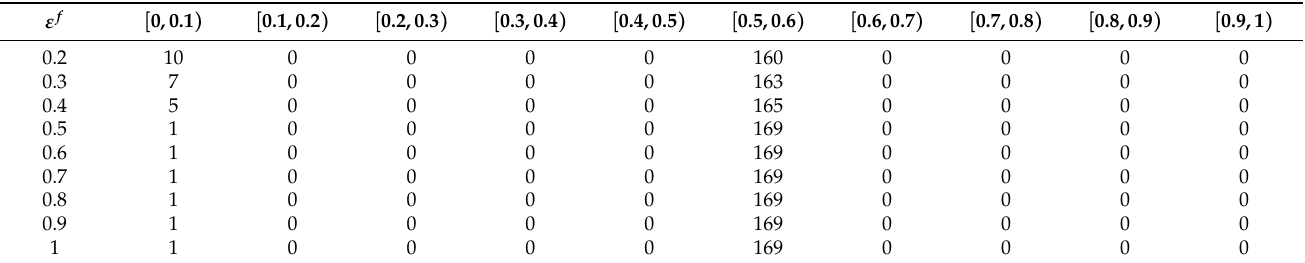
Table 3. Number distribution of all individuals in different ranges when ε l = 0.3 and ε f vary in [ 0,1 ] .